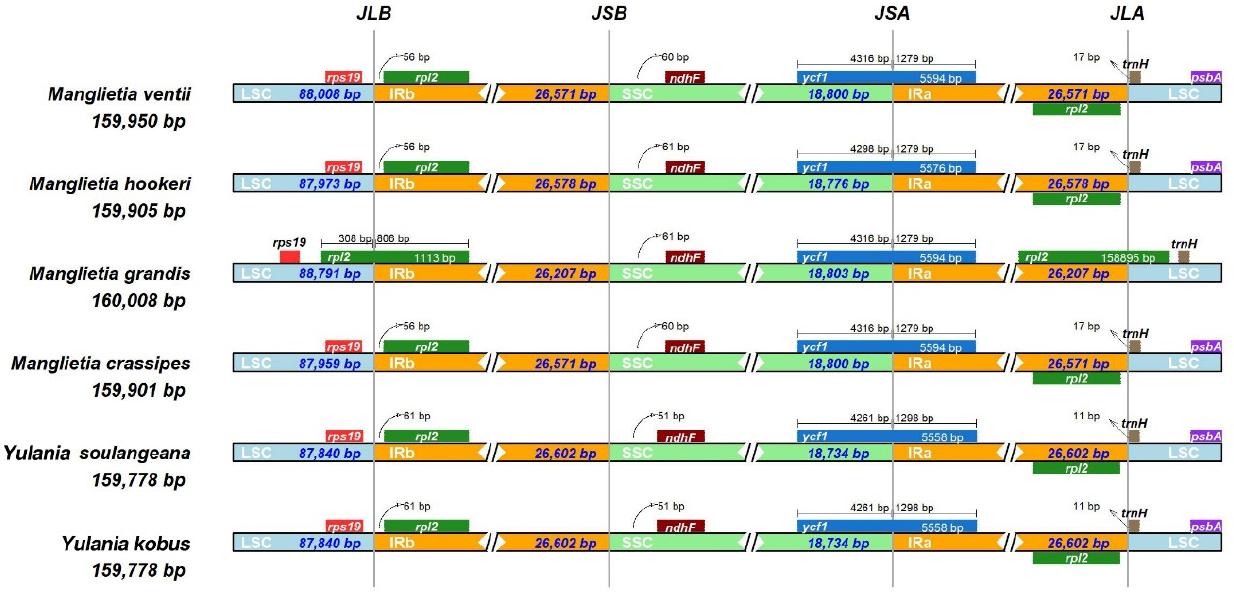
Figure 4. Comparison of the border regions of the six chloroplast genomes of Magnoliaceae. Note: Different genes are denoted by colored boxes. The gaps between the genes and the boundaries are indicated by the base lengths (bp).